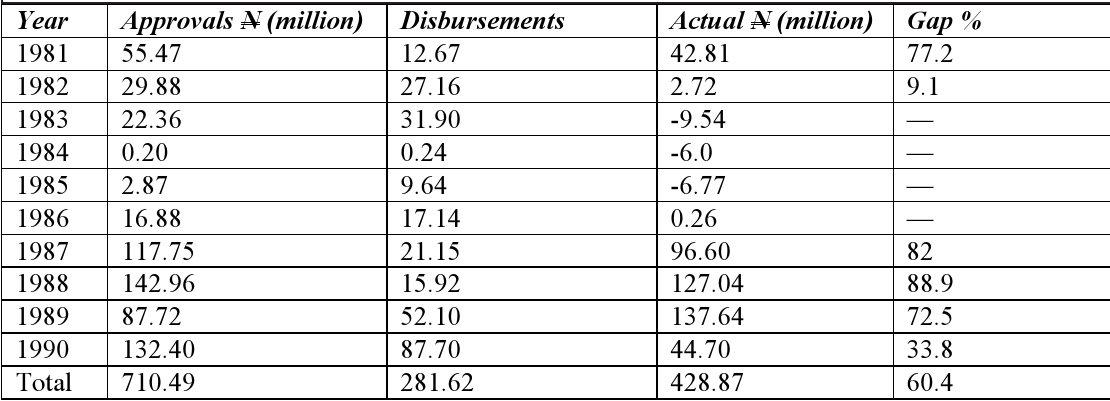
Table 4. Nigerian Industrial Development Bank Total Approval and Disbursements